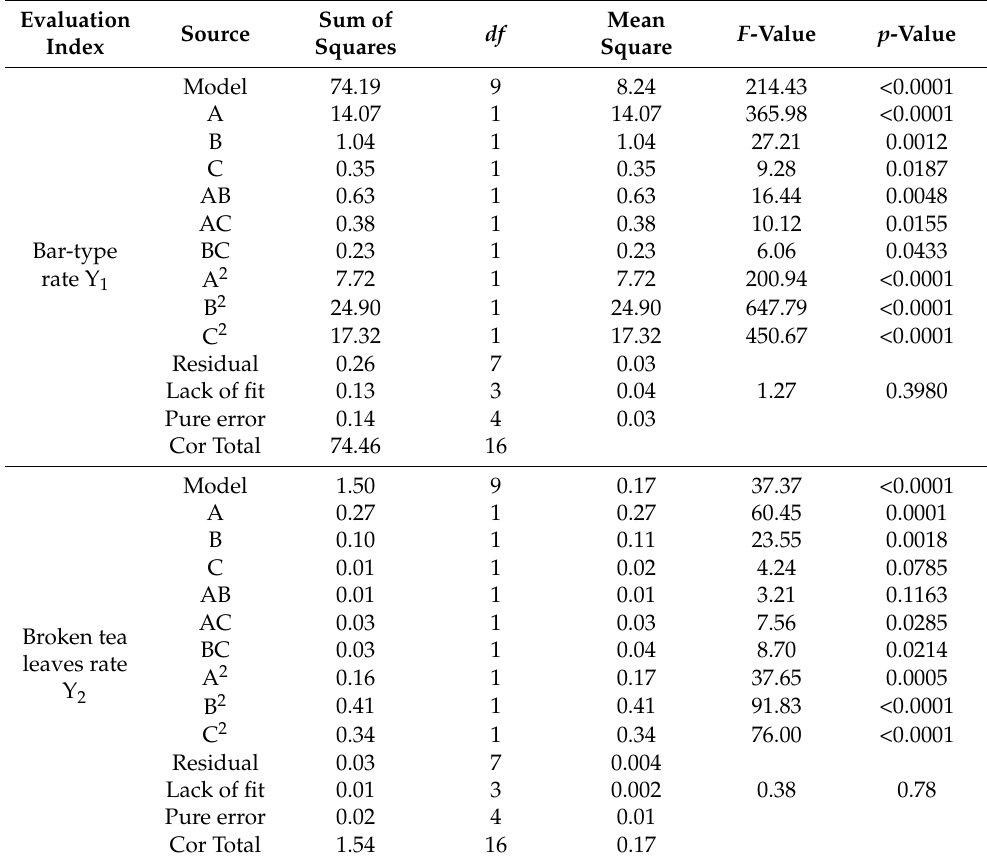
Table 5. Analysis of